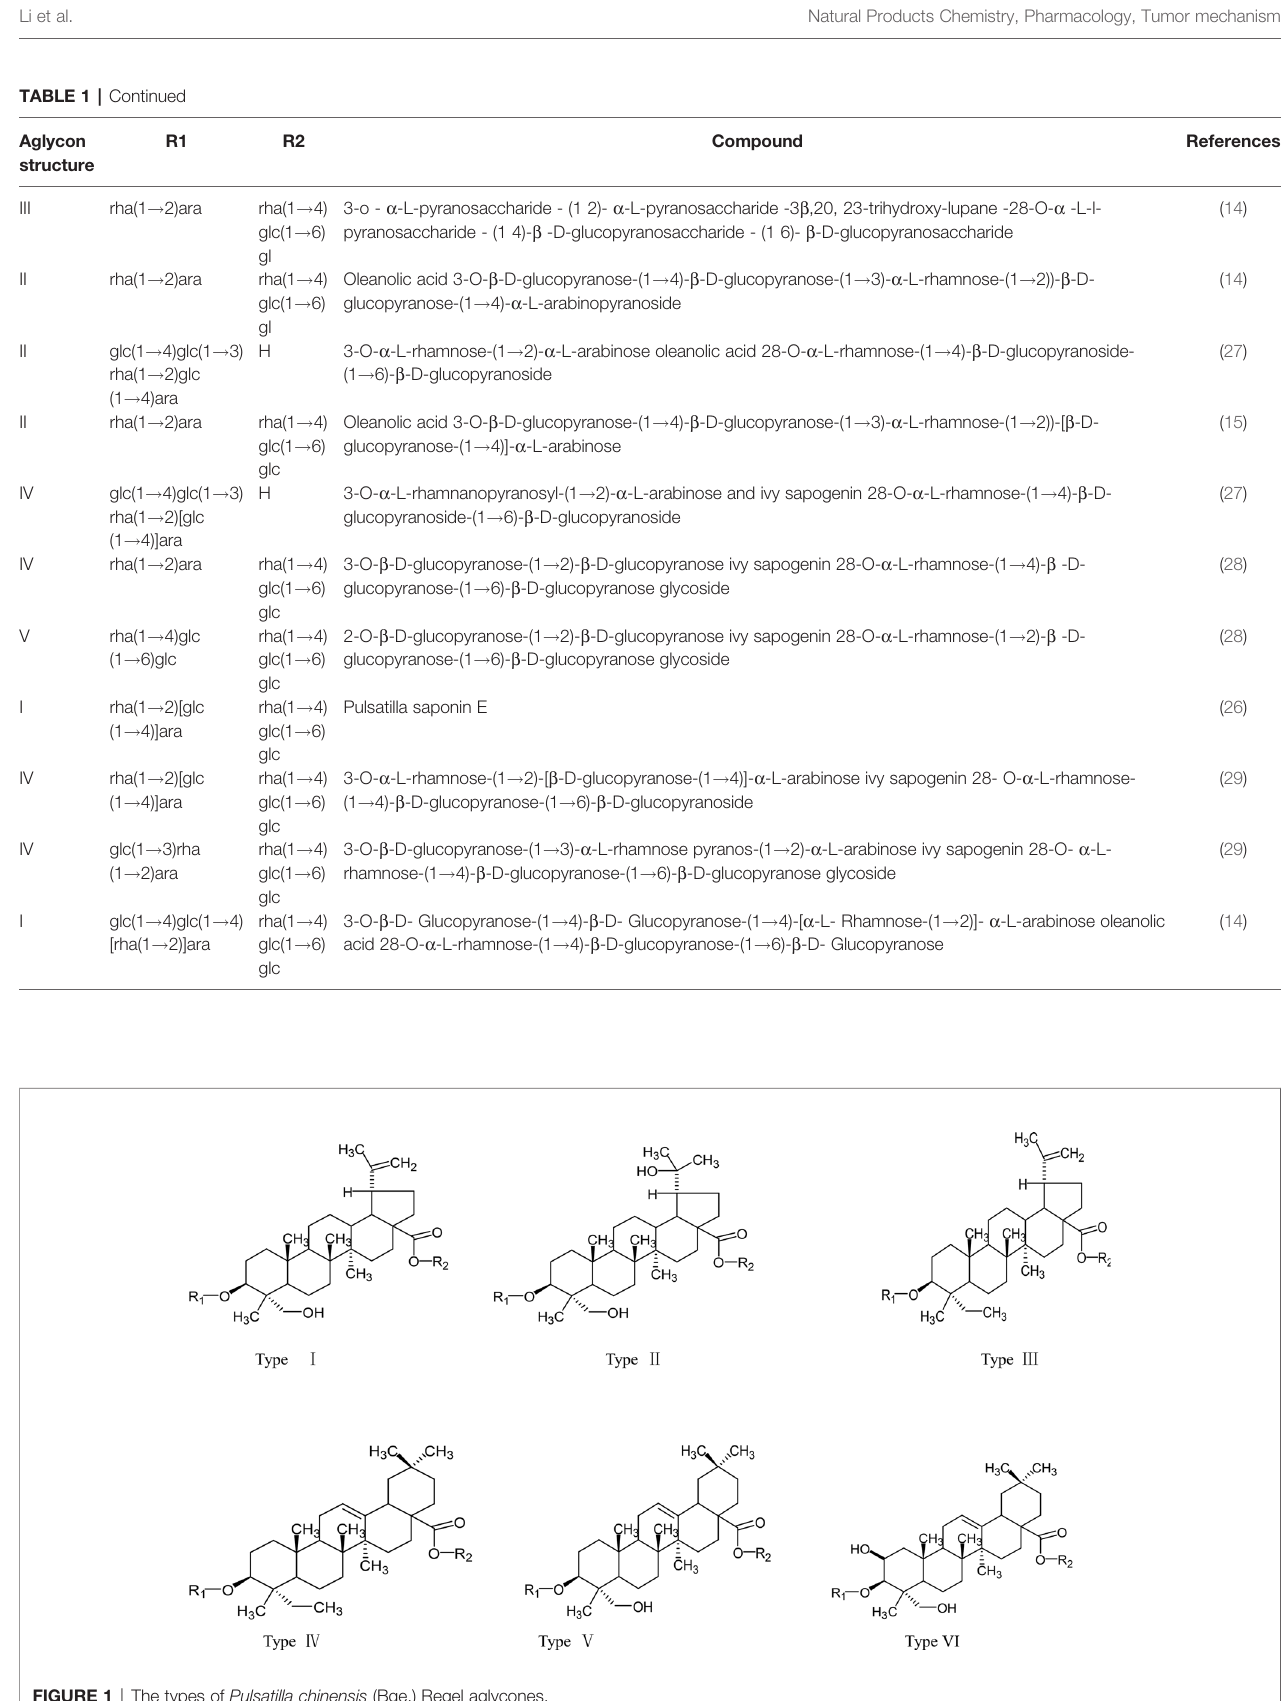
FIGURE 1 | The types of Pulsatilla chinensis (Bge.) Regel